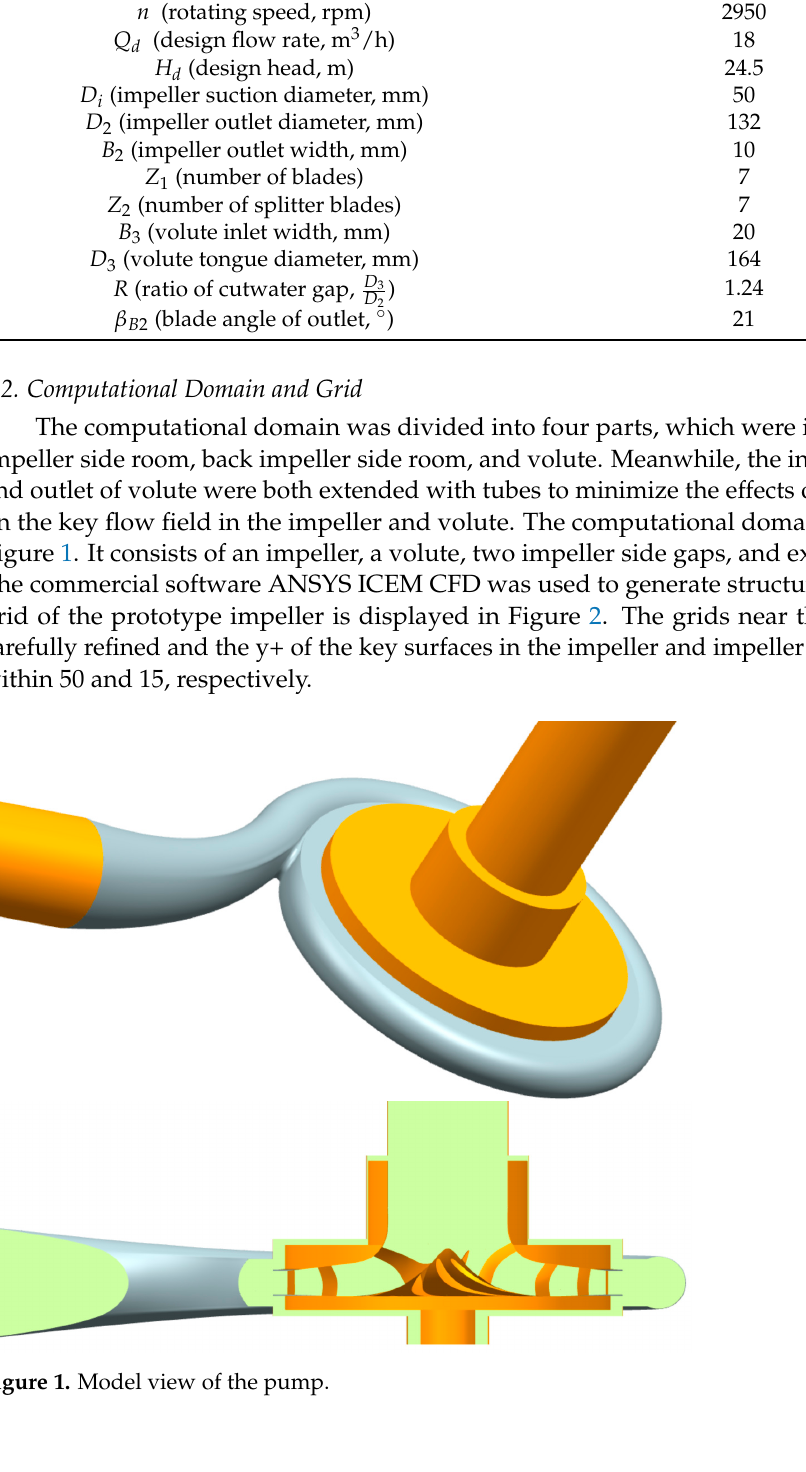
Figure 2. Mesh view of the prototype impeller.